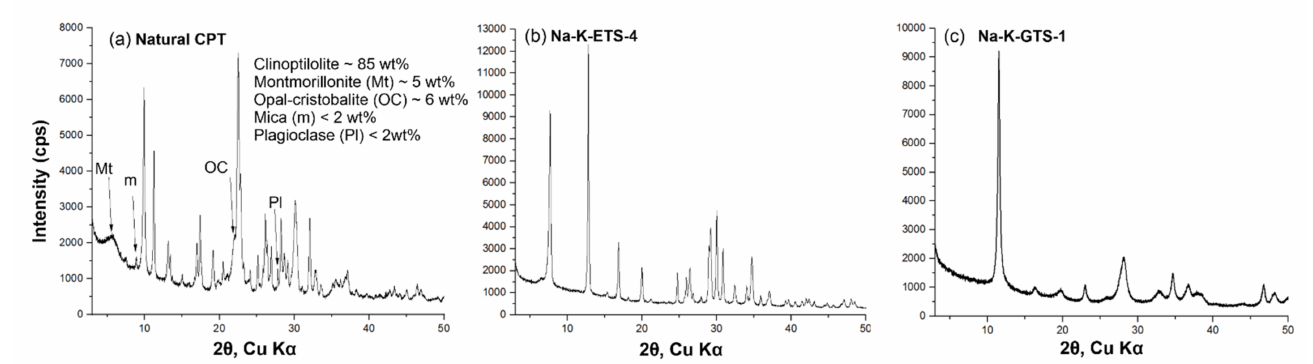
Figure 1. Powder XRD patterns of ( a ) natural CPT from the Beli Plast deposit, Bulgaria, ( b ) Na-K-ETS-4, and ( c ) Na-K-GTS-1. The diffraction peaks corresponding to the impurities in the clinoptilolite—e.g., montmorillonite (Mt), opal cristobalite (OC), mica (m), and plagioclase (Pl)—are marked with arrows. The SEM images of CPT, Na-K-ETS-4, and Na-K-GTS-1 are shown in Figure 2. Based